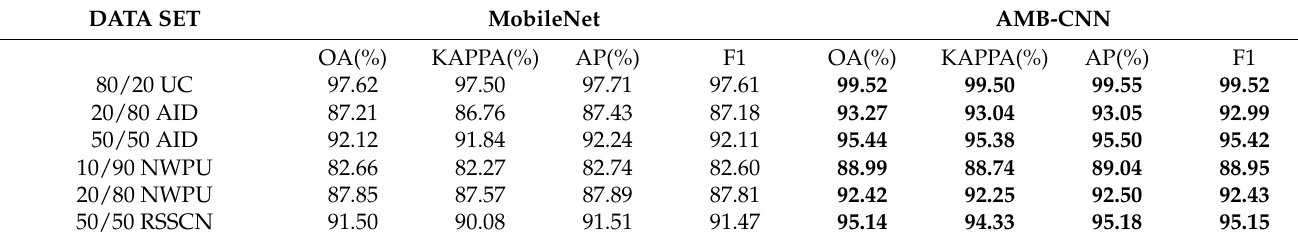
Table 1. Performance comparison between MobileNet and the proposed